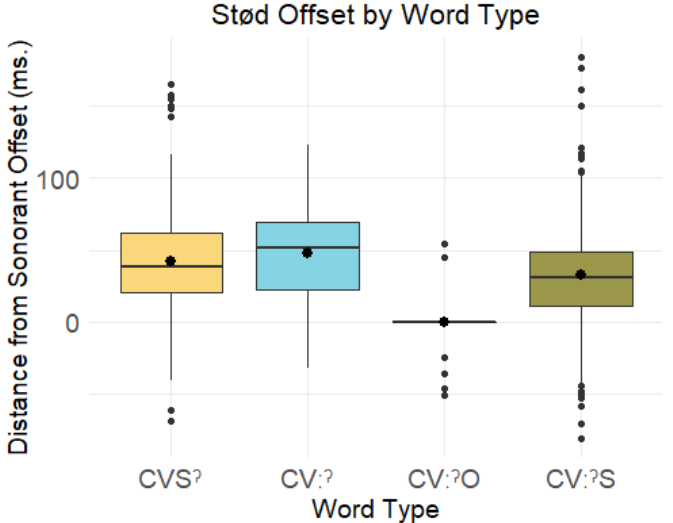
Figure 9. Stød offset in milliseconds by word type. CVS ˀ and CV ːˀ words have the latest stød offset times, which do not differ from each other. CV ːˀ S have earlier offset times, and CV ːˀ O words have the earliest offset times, which do not differ significantly from 0. Black dots indicate the mean stød offset time per word type.